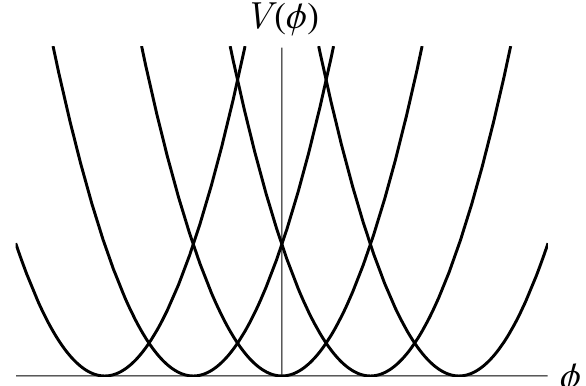
Figure 1 . The multi-branched potential of axion monodromy. Each branch of the potential is labeled by a distinct integer value of the discrete flux parameter f the gauge transformation φ → φ + 2 π , f